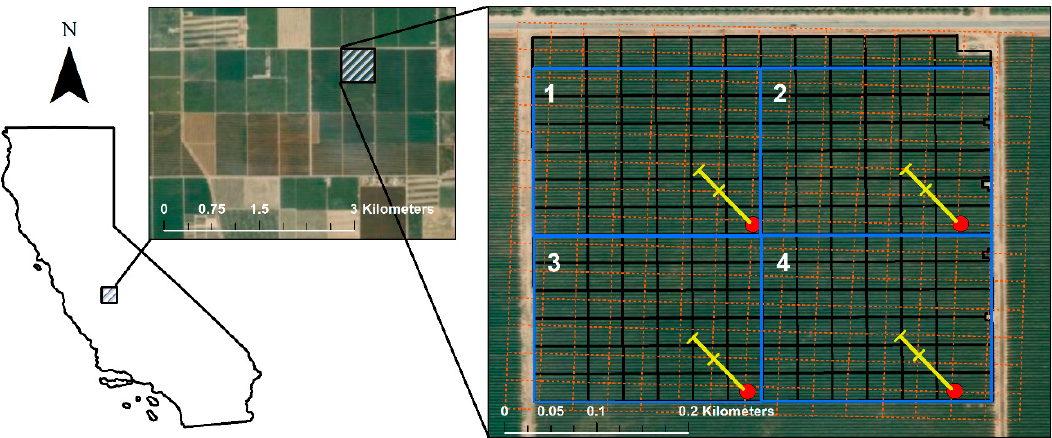
Figure 1. Location of the study area. The black grid represents the variable rate drip irrigation (VRDI) system over the entire vineyard. Orange dotted lines indicate 30 m resolution pixels in the Landsat WRS grid (UTM zone 10 N). Blue boxes highlight the four study blocks within the vineyard. Red dots represent the flux tower location within each study block. Yellow bars represent median and maximum fetch distances in the median wind direction.